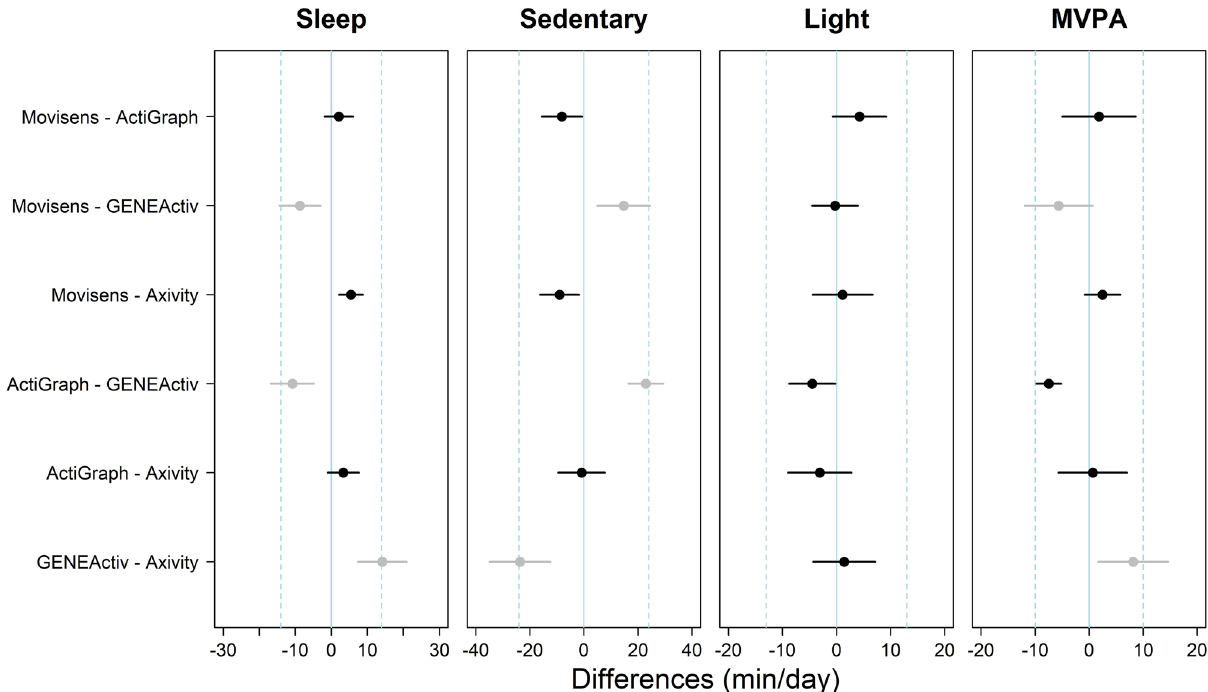
Figure 2. Equivalence between pairs of monitors for sedentary time, light, moderate, and vigorous PA. Points represent the difference in min/day between a pair of monitors (as determined in the vertical axis) for every PA metric. Error bars represent the CI 95% of the difference. Perfect equivalence = 0 (solid line); proposed equivalence zone (± 0.2 SDs of the differences) represented by dashed lines. Black markers indicate that the CI 95% are within the equivalence zone, and grey markers indicate that they go beyond the equivalence zone. CI 95% 95% confidence intervals, PA physical activity, SD standard